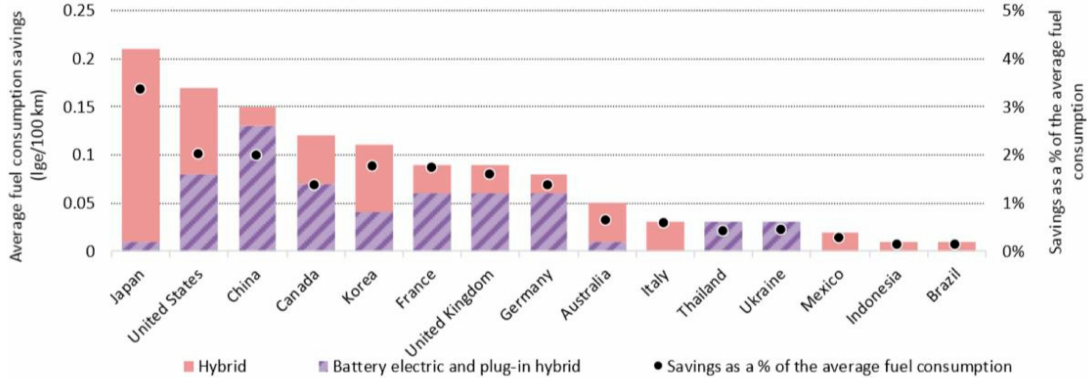
Figure 2. Contribution to the Fuel Consumption Savings from Electrified Vehicles in 2017